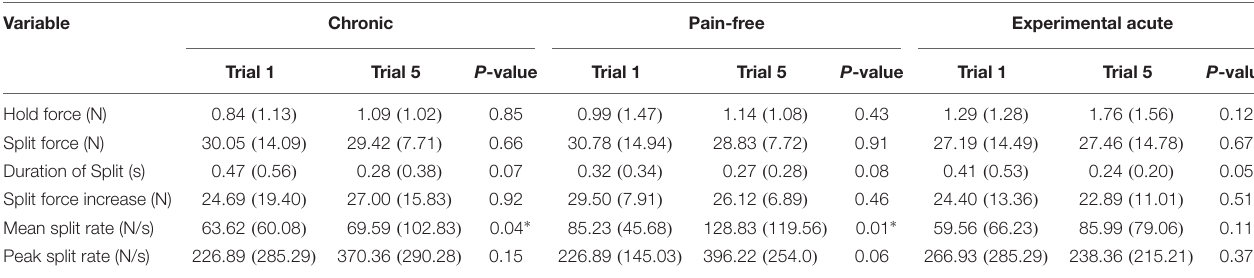
TABLE 2 | Changes compared to baseline values in force, duration and rate variables in the three conditions.